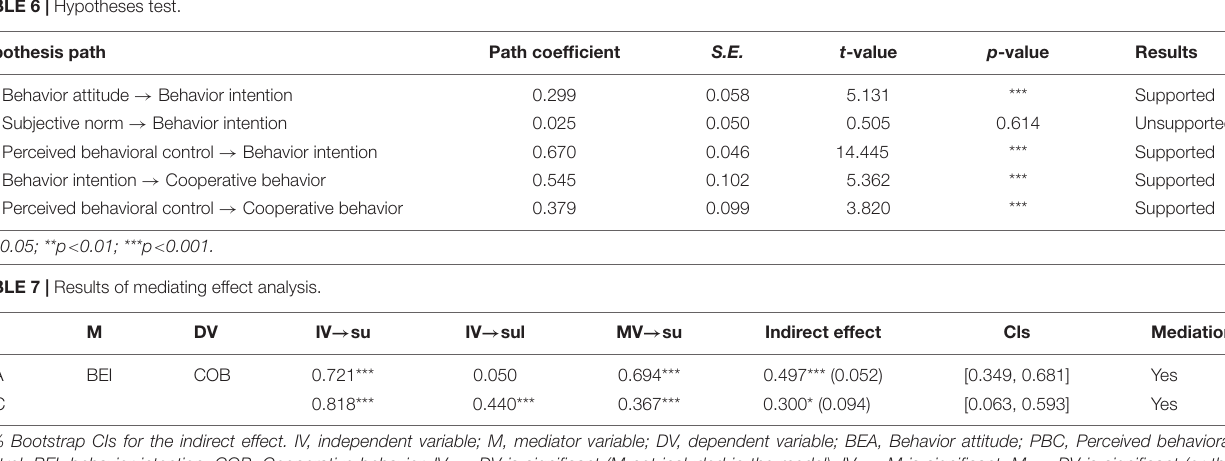
TABLE 6 | Hypotheses test.